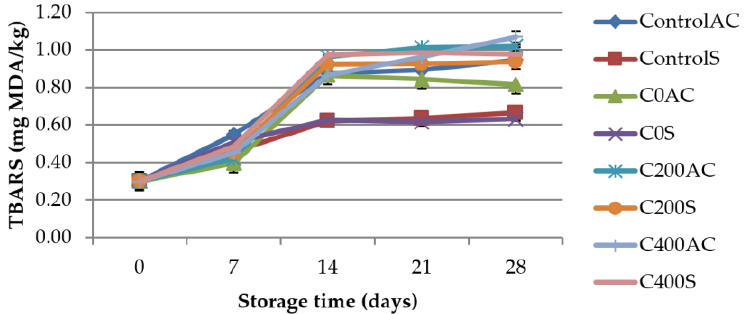
Figure 7. TBARS values for control samples and sausage samples covered with experimental sodium alginate coatings.